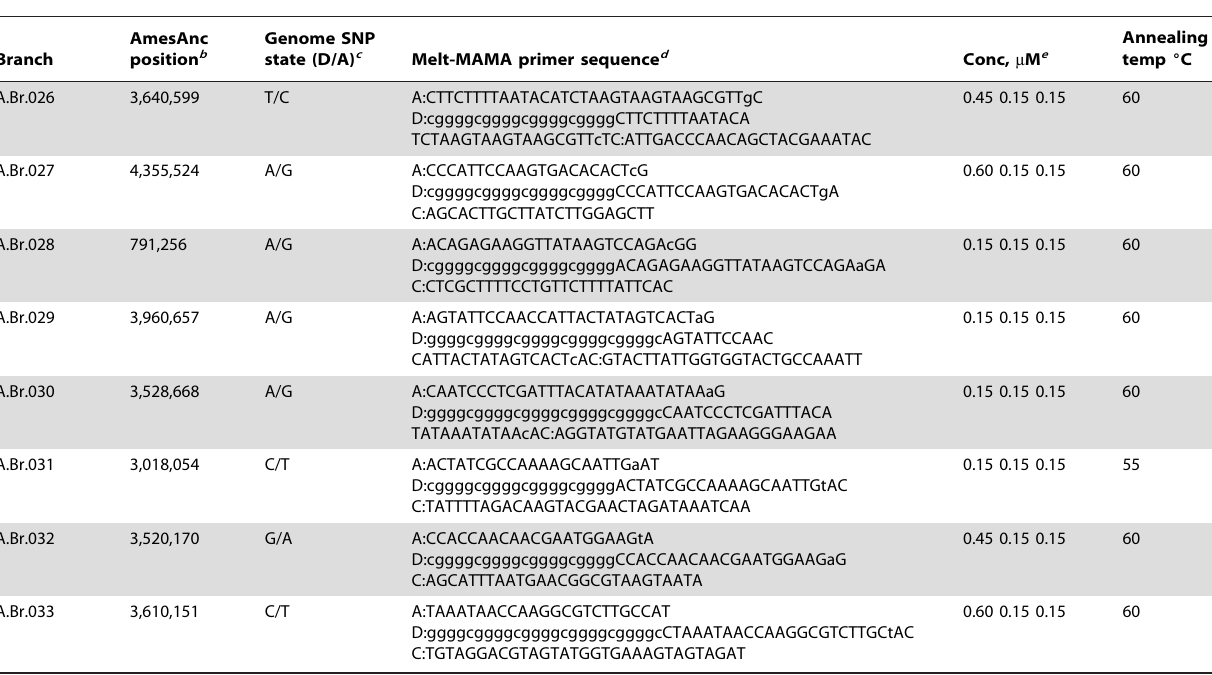
Table 1. Melt-MAMA primers targeting canonical SNPs for 8 new phylogenetic branches discovered in this study a .